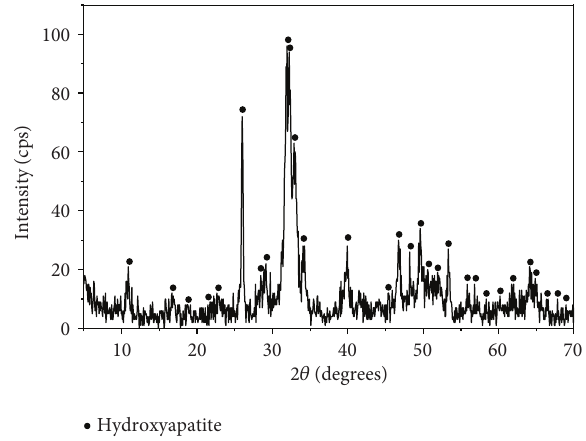
F 1: X-ray diffraction (XRD) pattern of synthetic hydroxyap- atite